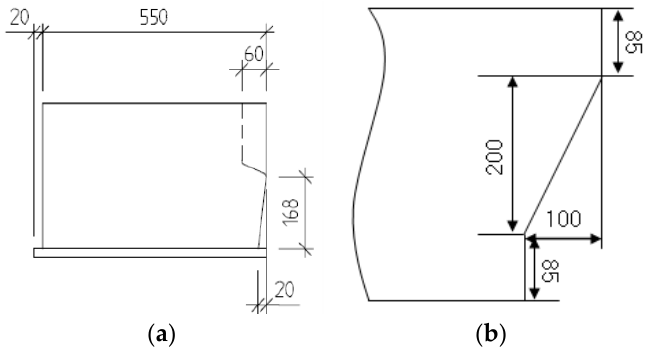
Figure 9. Layout of shear key (unit: mm): ( a ) Hällmark’s shear key example; and ( b ) specimen shear key dimensions.